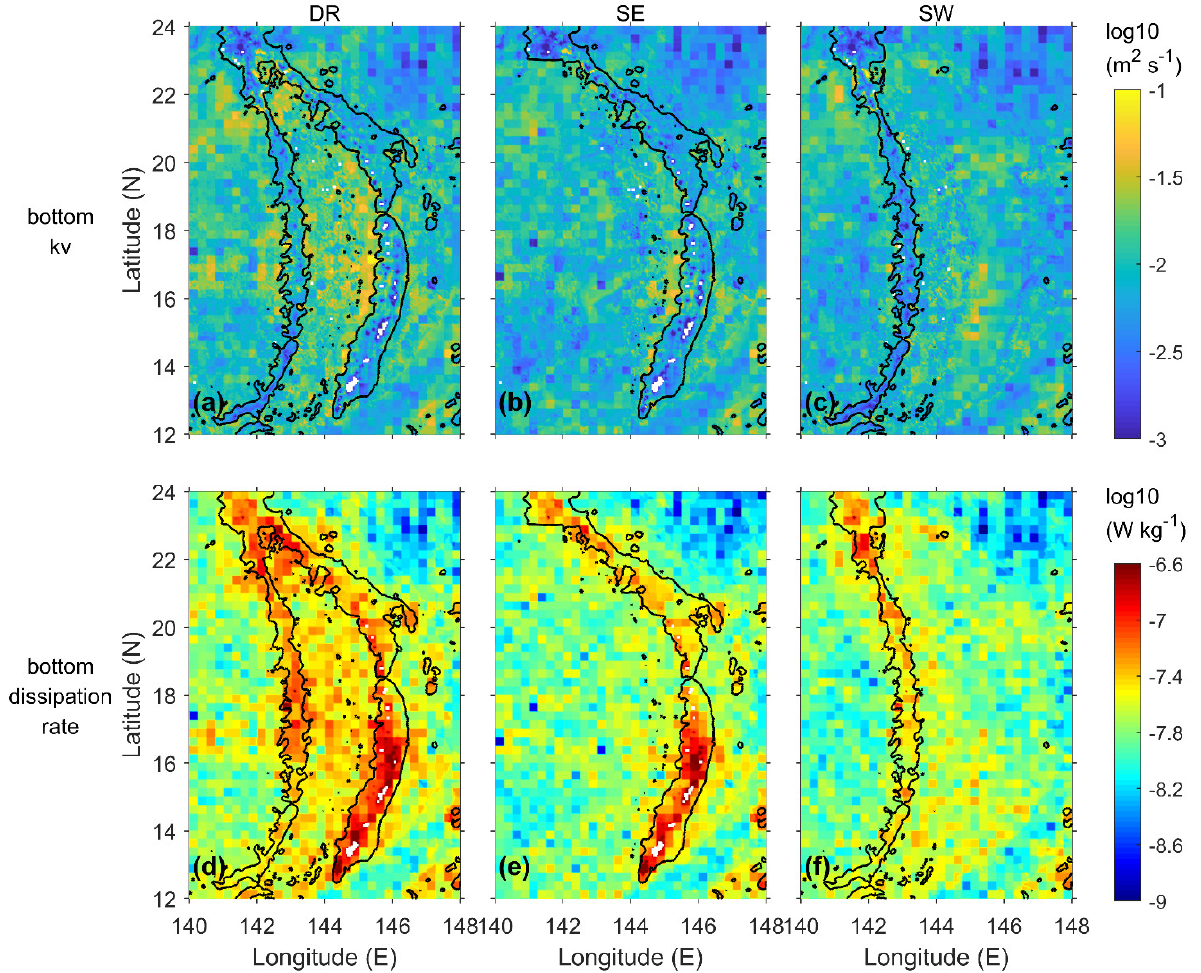
Figure 11. Bottom diapycnal diffusivity (m 2 s –1 ) under the DR ( a ), SE ( b ), and SW ( c ) cases (upper panel). Bottom dissipation rate (W kg –1 ) under the DR ( d ), SE ( e ), and SW ( f ) cases (lower panel). The background contours represent the 3000-m isobaths.